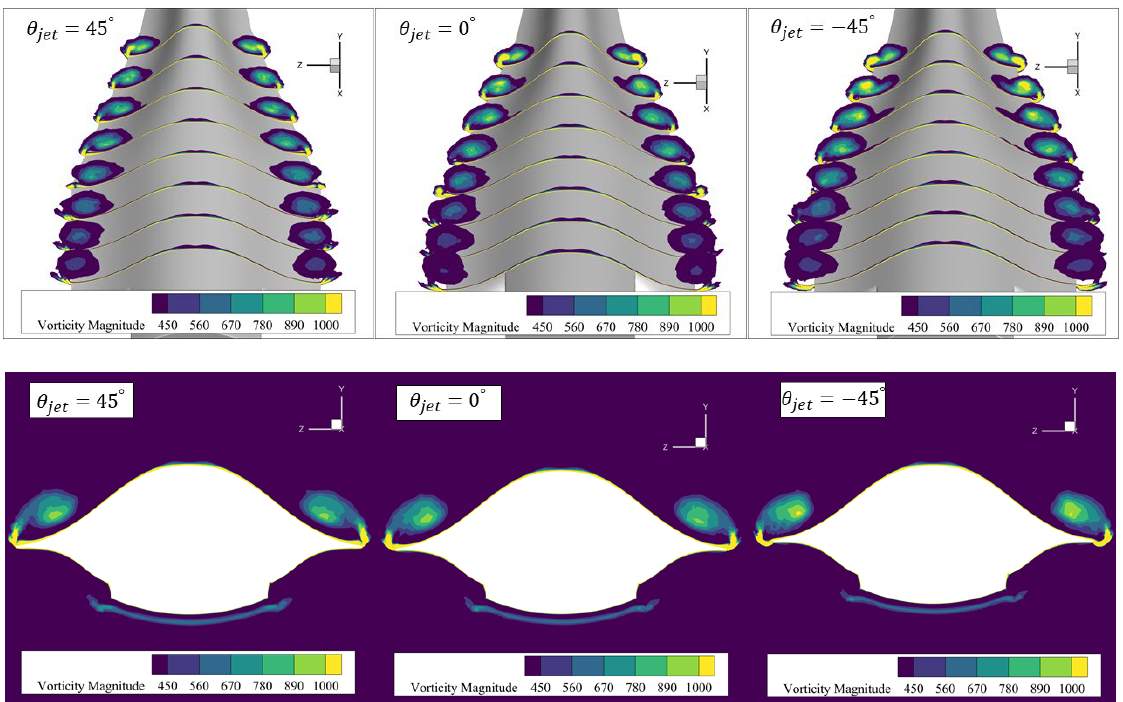
Figure 25. Comparison of the vorticity contours for different blowing directions at α = 10 ◦ , x / L 0 = 0.6.